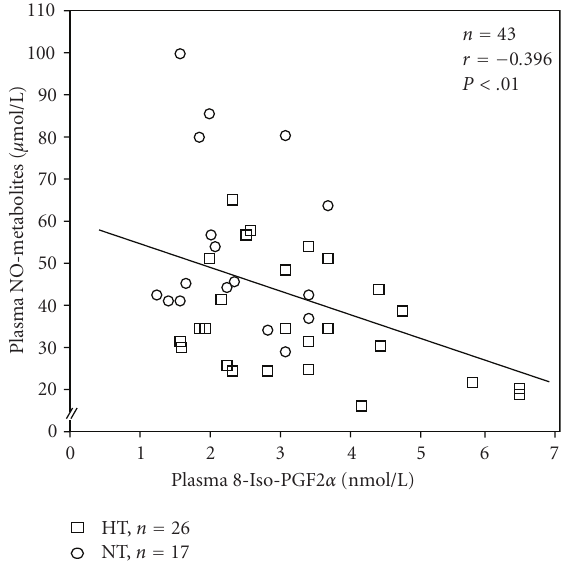
Figure 3: Correlation between plasma adiponectin and plasma nitric oxide (NO) metabolite levels in hypertensive and normoten- sive men.